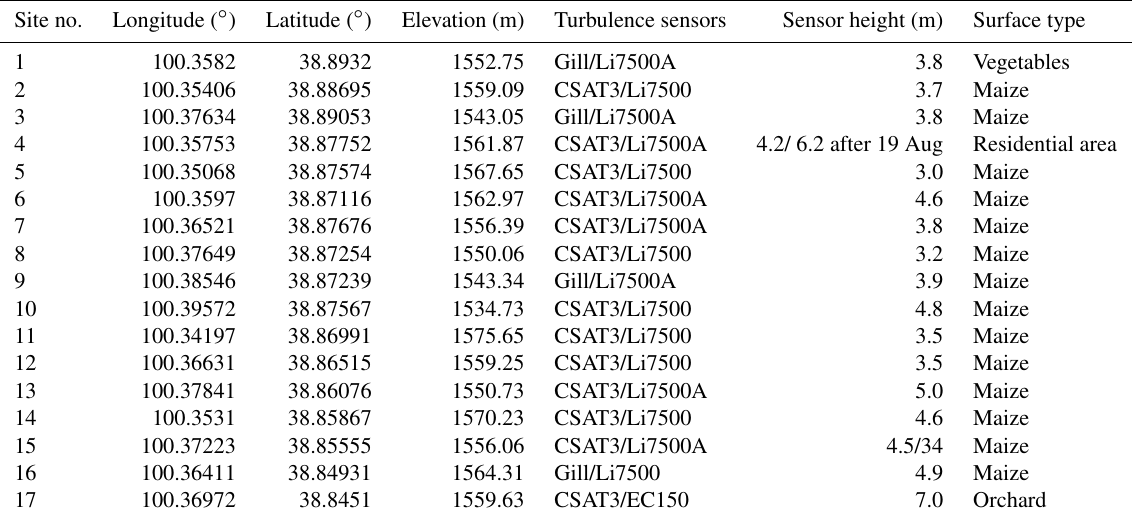
Table 1. Details of eddy-covariance systems in the HiWATER flux matrix. Site no.